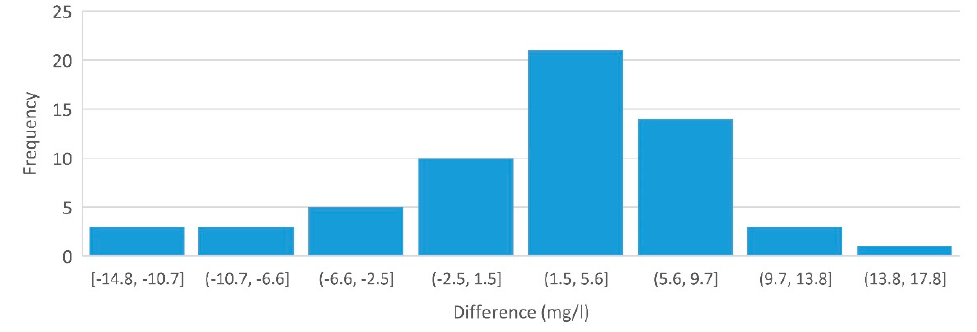
Figure 10. Histogram of differences between the observed and modeled nitrate concentrations at the observation locations.